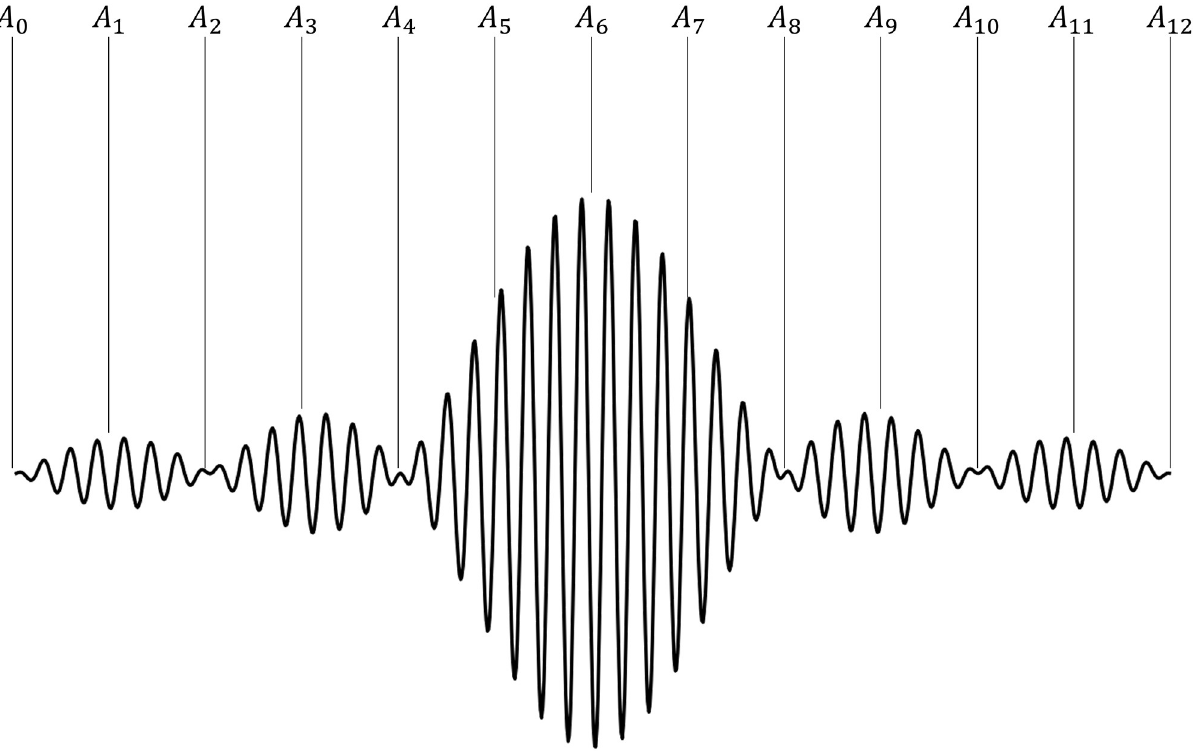
Fig 2. Example of the sinc pulse ( N 0 = 3, i = 1, N S = 13).